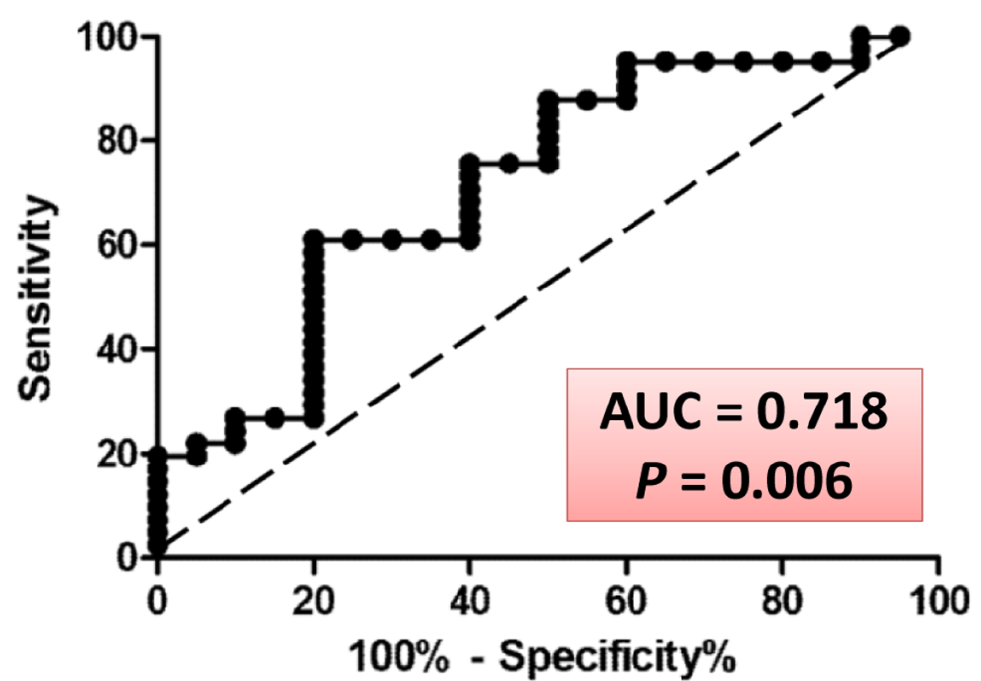
Figure 7. ROC curve for the effect of grape consumption on urinary 2 ′ -deoxyribonic acid (responders vs. non-responders for UV skin MED). There is a 71.8% probability ( p = 0.006) that measurement of urinary 2 ′ -deoxyribonic acid identifies an individual who will not exemplify greater resistance to UV irradiation following grape consumption.